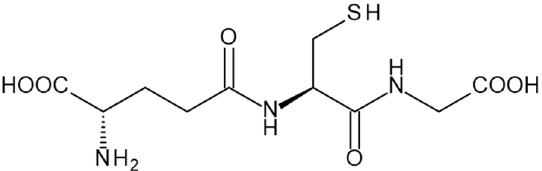
Figure 1. Chemical structure of the tripeptide glutathione ( γ -Glu-Cys-Gly).